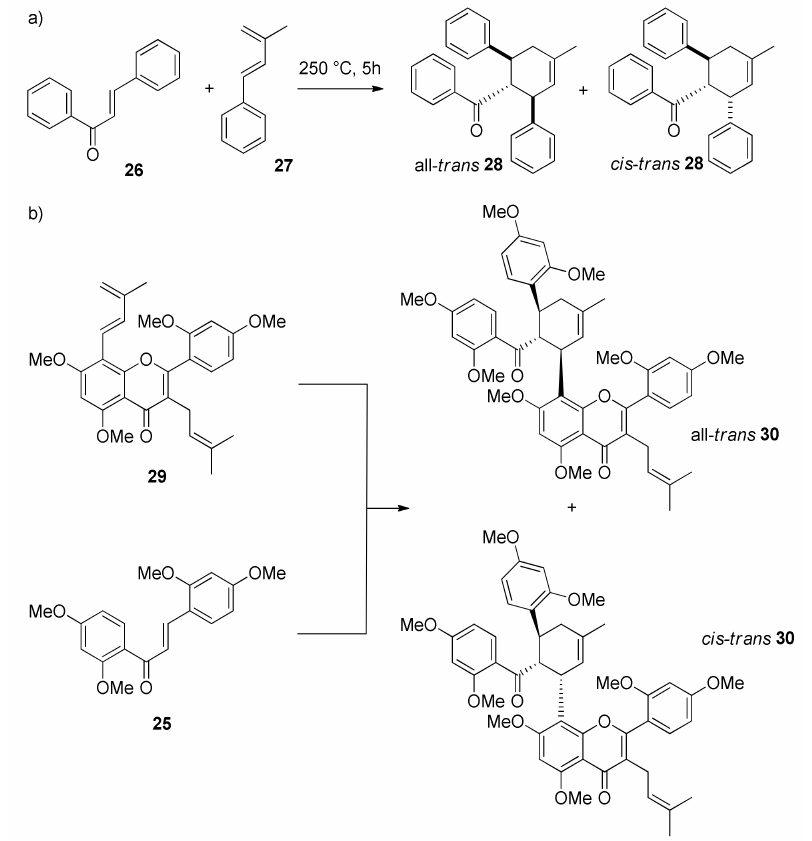
Figure 8. Diels–Alder reaction of ( a ) model chalcone 26 with dehydroprenyl benzene 27 and ( b ) py- rolysis products of kuwanon G octamethyl ether ( 30 ) affording endo- or exo -adducts of the same unique regioisomer.